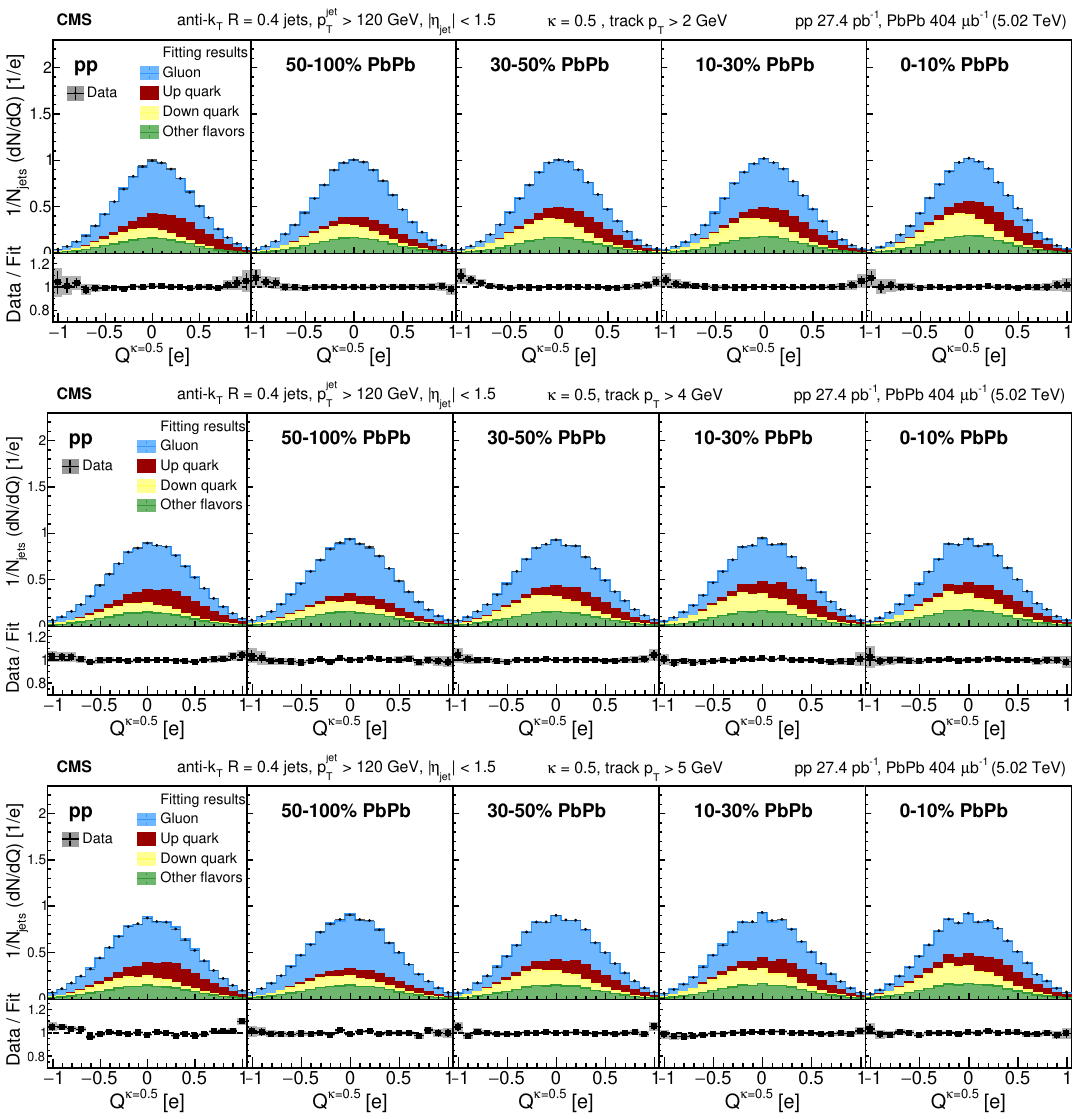
Figure 5 . (Upper row of each (cid:12)gure) Unfolded jet charge measurements shown for inclusive jets in data along with the extracted fractions of up, and down quark jets, gluon jets, and the \other (cid:13)avor" jets. The systematic and statistical uncertainties in the distributions are shown by the shaded regions and vertical bars, respectively. The jet charge measurements shown here are for (cid:20) = 0 : 5 and a minimum track p of 2, 4, and 5 GeV (top, middle, and bottom, respectively). T (Lower row of each (cid:12)gure) Ratio of the jet charge measurements to the results of template (cid:12)ts.